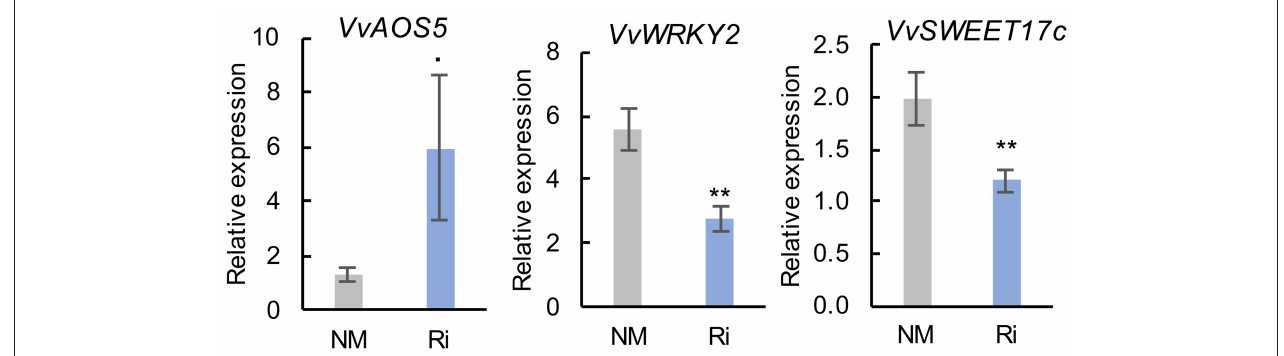
FIGURE 9 | Expression of genes related to defense responses and sugar transport and metabolism in leaves of NM and Ri plants. Expression was studied by RT-qPCR 2 months after mycorrhization. Transcript levels were normalized to V. vinifera ACTIN and EF1 α transcript levels. For each gene, relative expression was obtained with the 2 − 11 CT method and indicates mean normalized expression in the different conditions compared with normalized expression in the plant, showing the lowest expression level (highest CT value), which was set to 1. Data are the mean ± SE of 12 independent biological replicates for VvAOS5 , VvSWEET17c , and VvWRKY2 . Asterisks indicate significant difference in gene expression between NM and Ri conditions (Kruskall and Wallis, ** p < 0.01, * p < 0.05, · p <